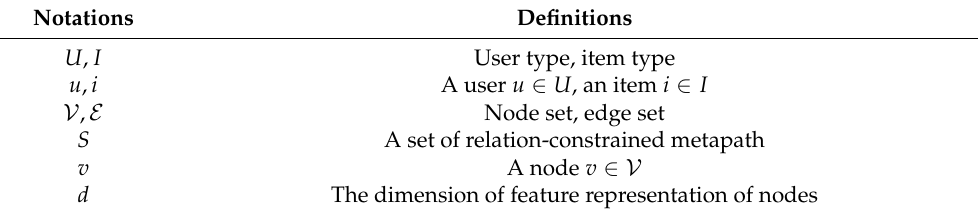
Table 1. Notations used in the